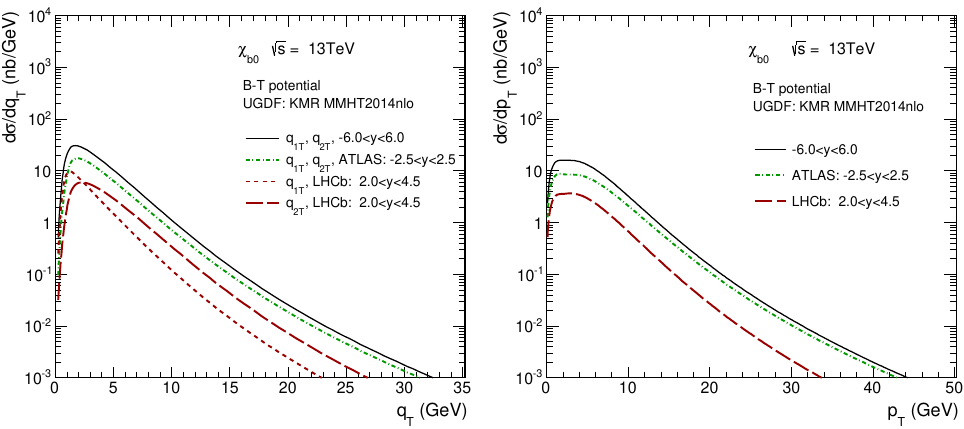
Figure 14 . Di(cid:11)erential cross section as a function of the transverse momentum of initial gluon ( q 1 T or q 2 T ) with rapidty cuts for the ATLAS and LHCb experiments. On the r.h.s. di(cid:11)erential cross section as a function of the transverse momentum of (cid:31) b with rapidity cuts for the ATLAS and LHCb